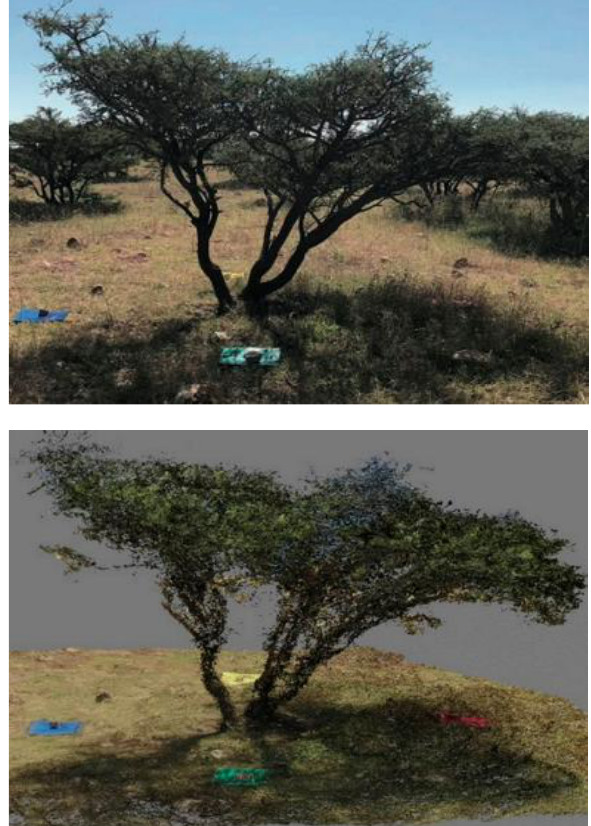
Figure 4. A reconstruction of sample tree (above) based on a UAV-derived point cloud image (below) (Sakai et al.,